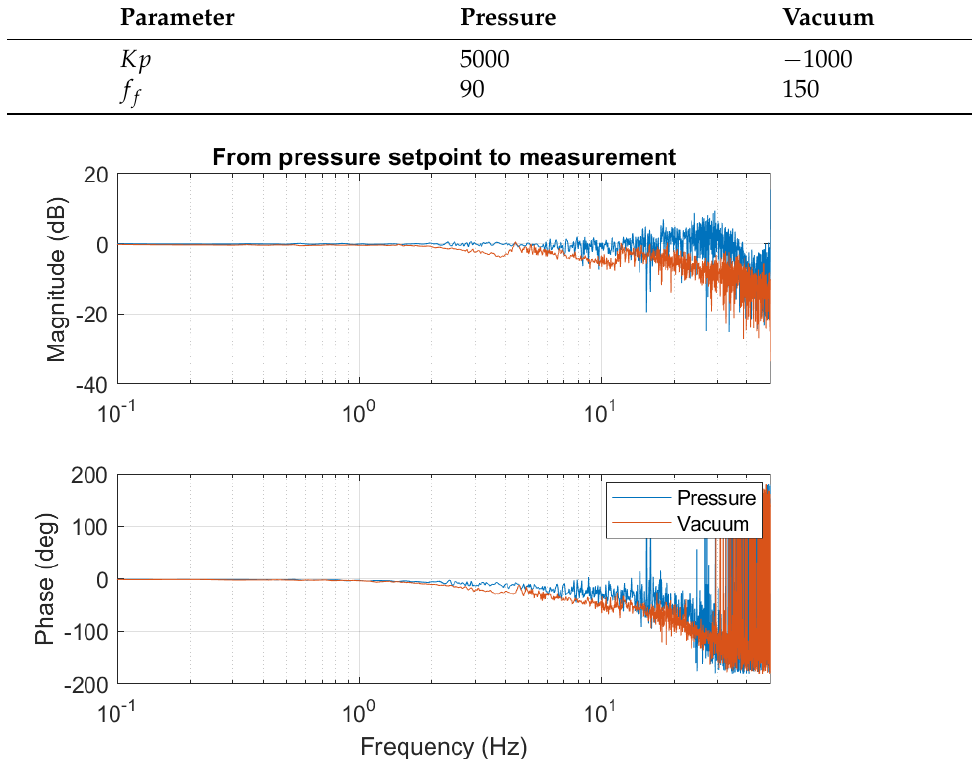
Figure 24. The closed loop frequency response of the Flowerbed pressure